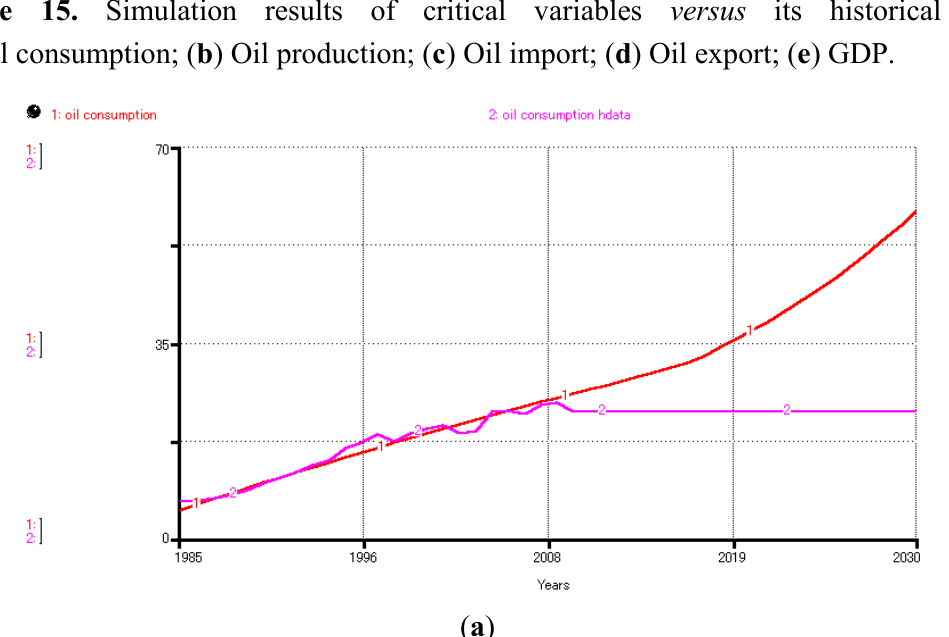
Figure 15. Simulation results of critical variables versus its historical